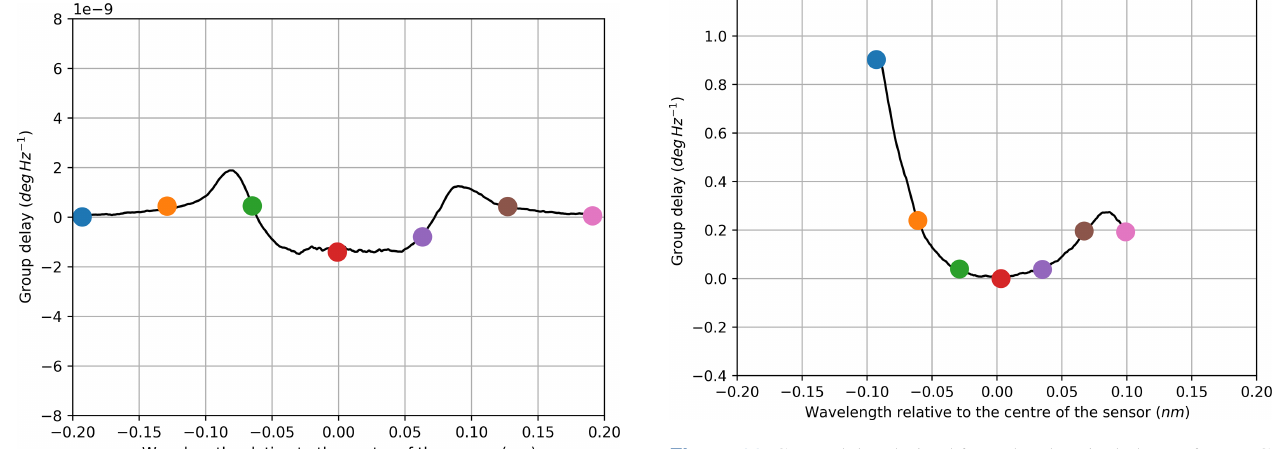
Figure 11. Group delay derived from the electrical phase of an FBG in reflection